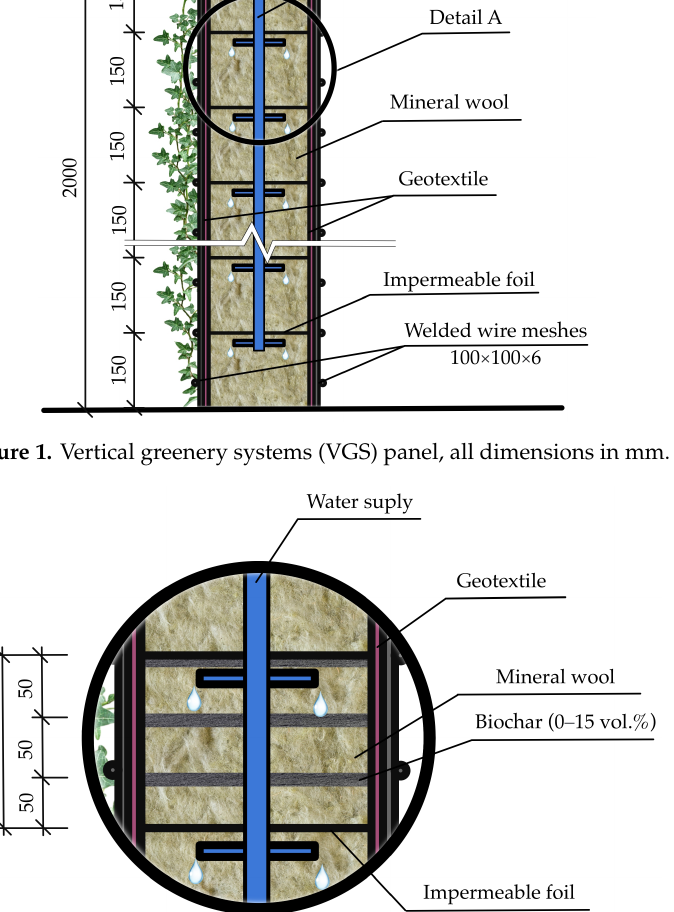
Figure 2. Detail of VGS panel, all dimensions in